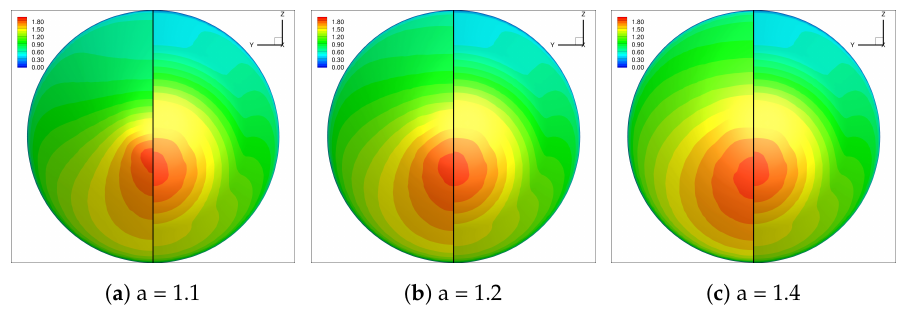
Figure 8. Pressure coefficient distribution on the forebody of the capsules with hyperbolic contours at an AoA of 15